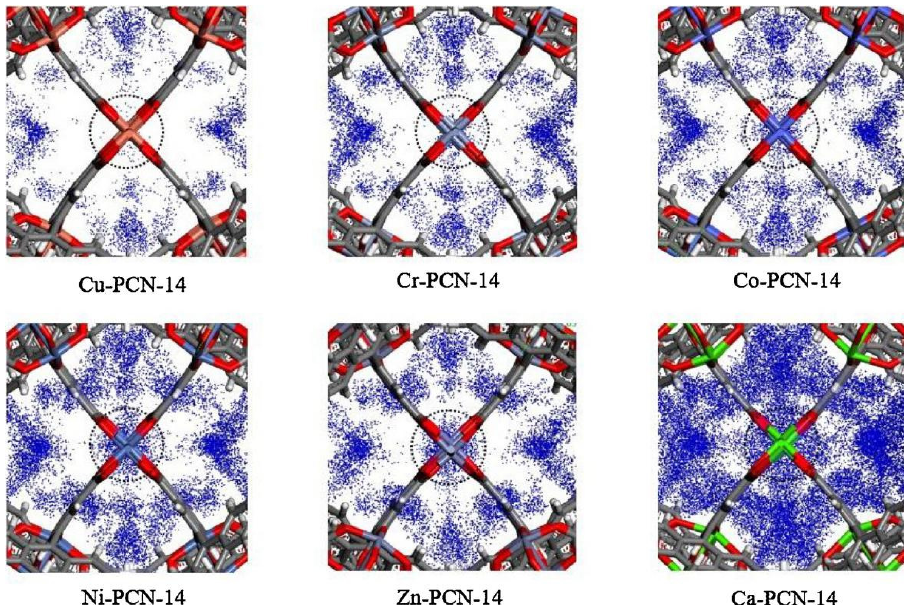
Figure 5. 14CH 4 density at the OMS of M-PCN-14 at 5 Bar of methane [54]. (3) ZIF